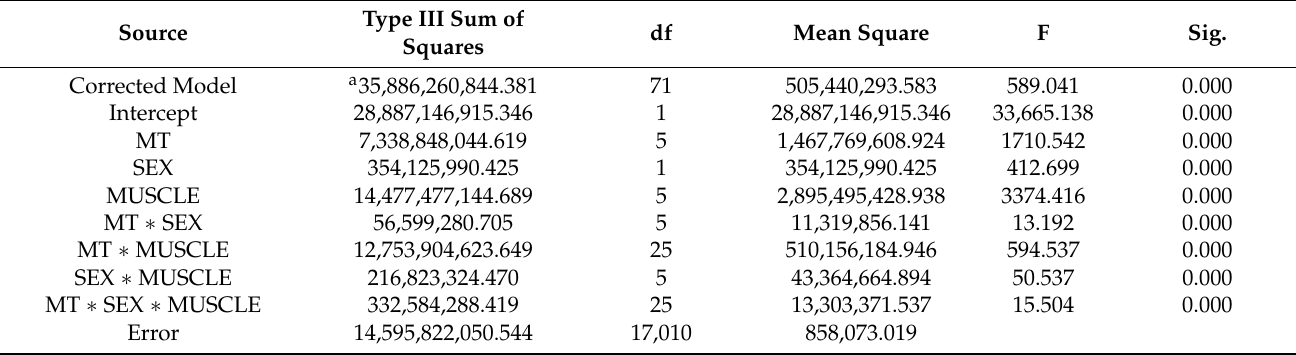
Table 7. Tests of between-subject effects (dependent variable: iEMG